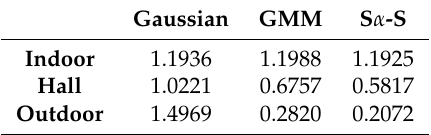
Table 2. Performance of data probability density function fitting by the root mean square